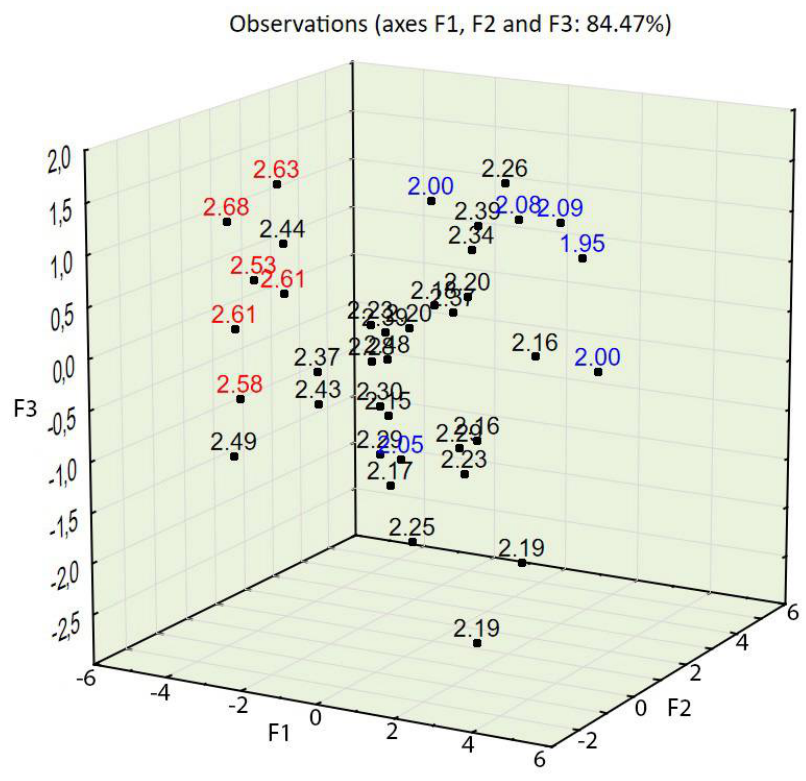
Figure 10. PCA with object grouping in a three-dimensional space on the basis of concrete composition in relation to properties. Splitting tensile strength: red represents a strength over 2.5 MPa, and blue represents a strength below 2.10 MPa.